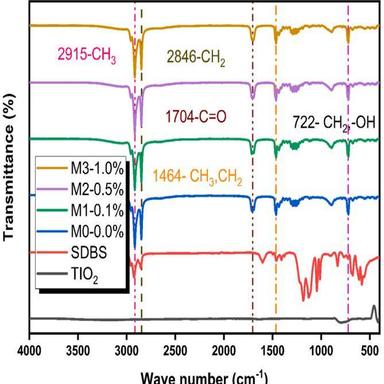
FT-IR spectrum of the eutectic base, TiO2, NeUPCMs. Fig. 5. TGA Curves for the composites.